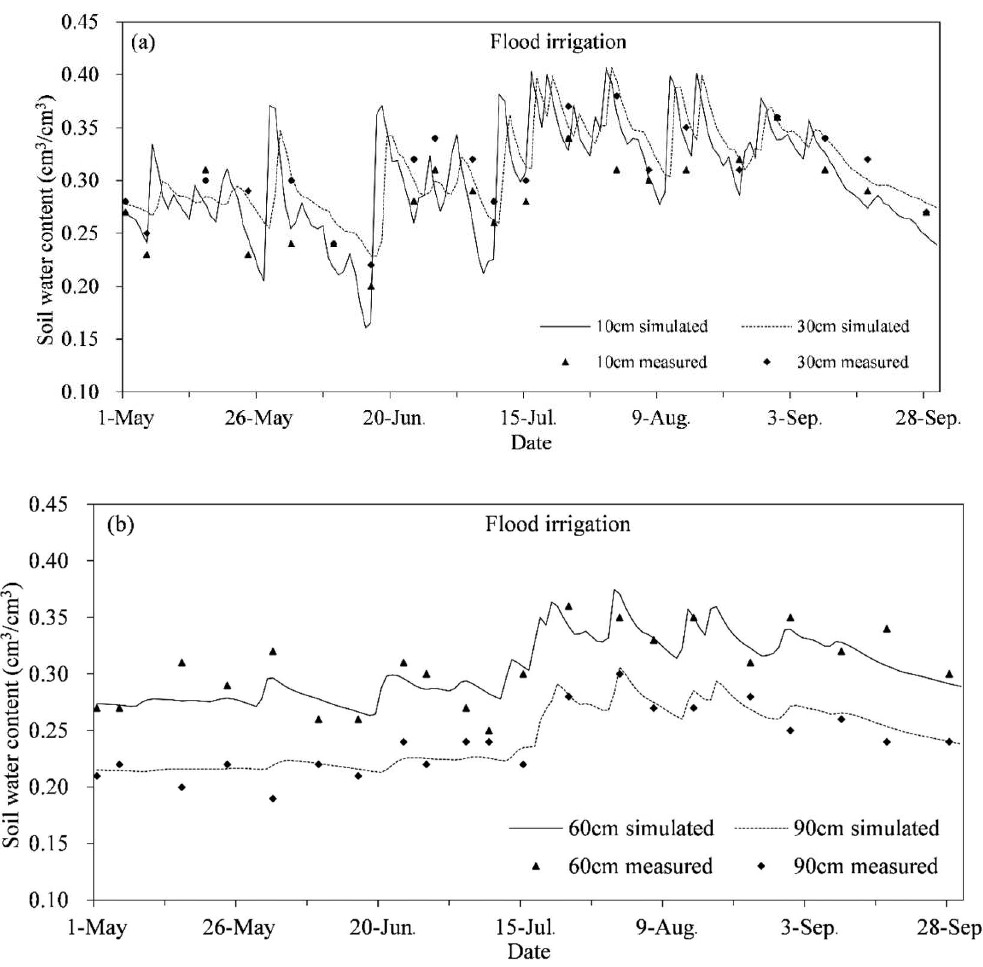
Table 3. The optimized soil hydraulic parameters used for the Hydrus-2D.